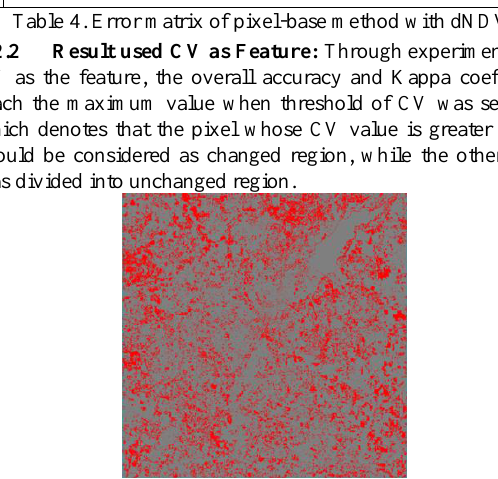
Figure 5. Change detection result of pixel-base method with CV